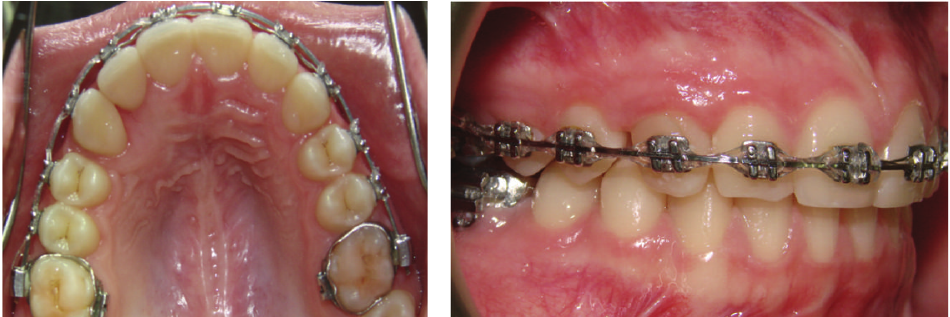
Figure 6: Intraoral photos after 2 months of using the NiTi wire